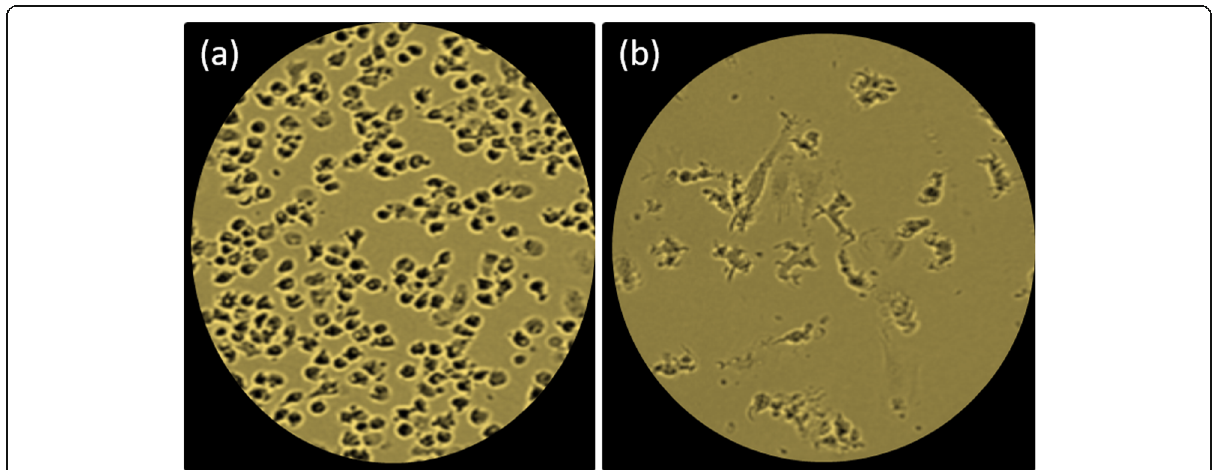
Fig. 1 Microscopic image showing morphological changes during in vitro culture of monocytes and the generation of dendritic cells (× 40). a Morphologic appearance of cultured adherent monocytes on day 0; the cells were small and rounded with a large nucleus. b Generated immature DCs on the day; cells were semi-adherent with multiple projections